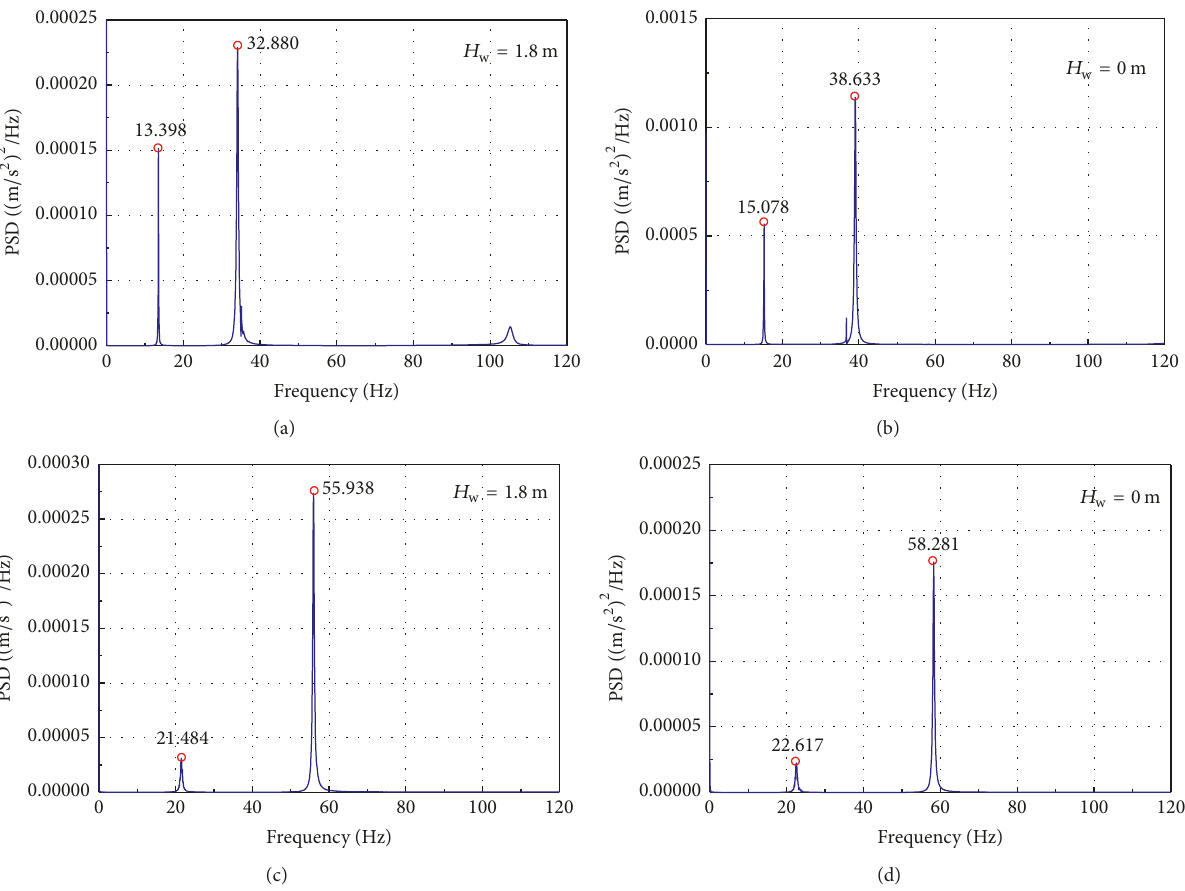
Figure 7: Power spectral density curves transformed from the acceleration signals shown in Figure 6, corresponding to (a) 𝐻 w = 1.8 m along 𝑥 -axis; (b) 𝐻 = 0 m along 𝑥 -axis; (c) 𝐻 = 1.8 m along 𝑦 -axis; (d) 𝐻 = 0 m along 𝑦 w w w